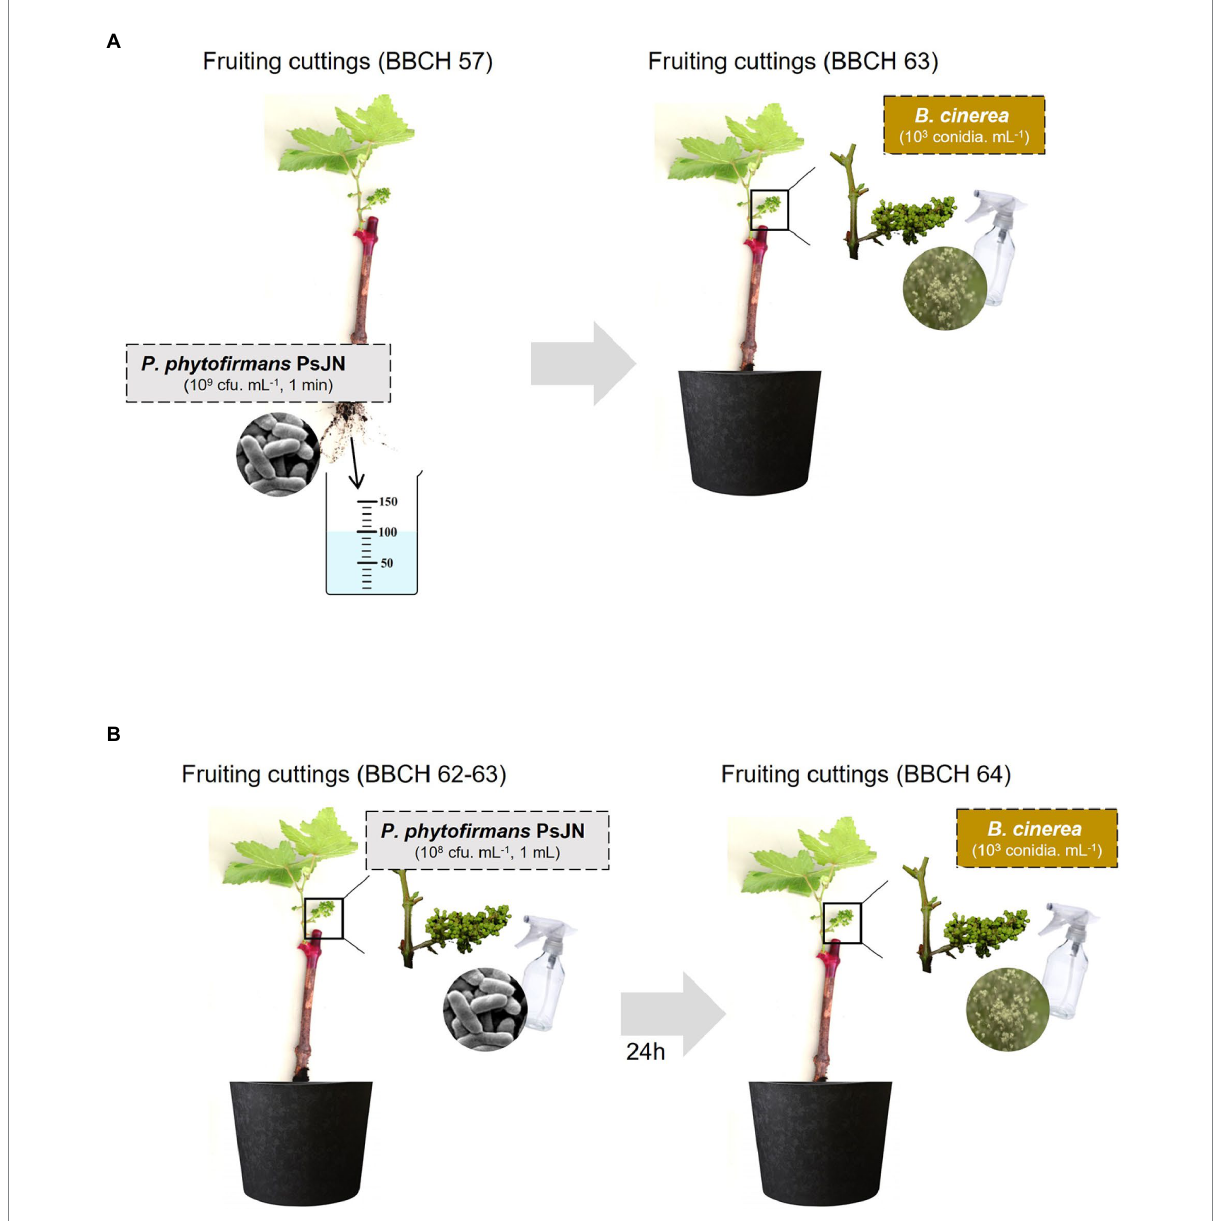
FIGURE 1 Modes of Paraburkholderia phytofirmans PsJN inoculation ( A : by root, B : by spraying) and Botrytis cinerea infection used in this